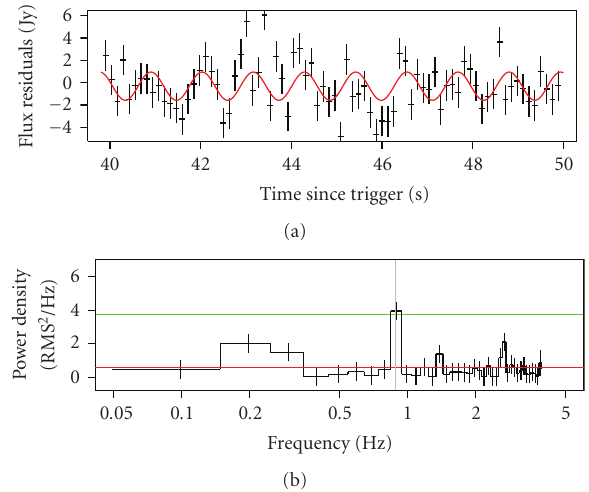
Figure 6: (a) Optical flux for a T +40s– T +50s interval (last peak) with the approximation shown in Figure 5 subtracted. Smooth line shows the best-fit sinusoidal approximation of the data with P = 1 . 13s period. (b) Power density spectrum of this data, estimated by bootstrapping method—by generating a large number of sample time series by randomly shu ffl ing the original light curve, what completely destroys its time structure while keeping the distribution of its values, and by studying the distribution and quantiles of resulting power densities. Horizontal lines represent mean noise level (lower) and a level of noise deviations with 10 − 3 significance (upper), estimated by bootstrapping number of time series from the original data set. Vertical line corresponds to the period of the sinusoidal approximation shown in (a), clearly coincided with the peak of power spectrum. The probability of a random appearance of a feature like the one seen in any of 39 frequency bin is ∼ 0.01.